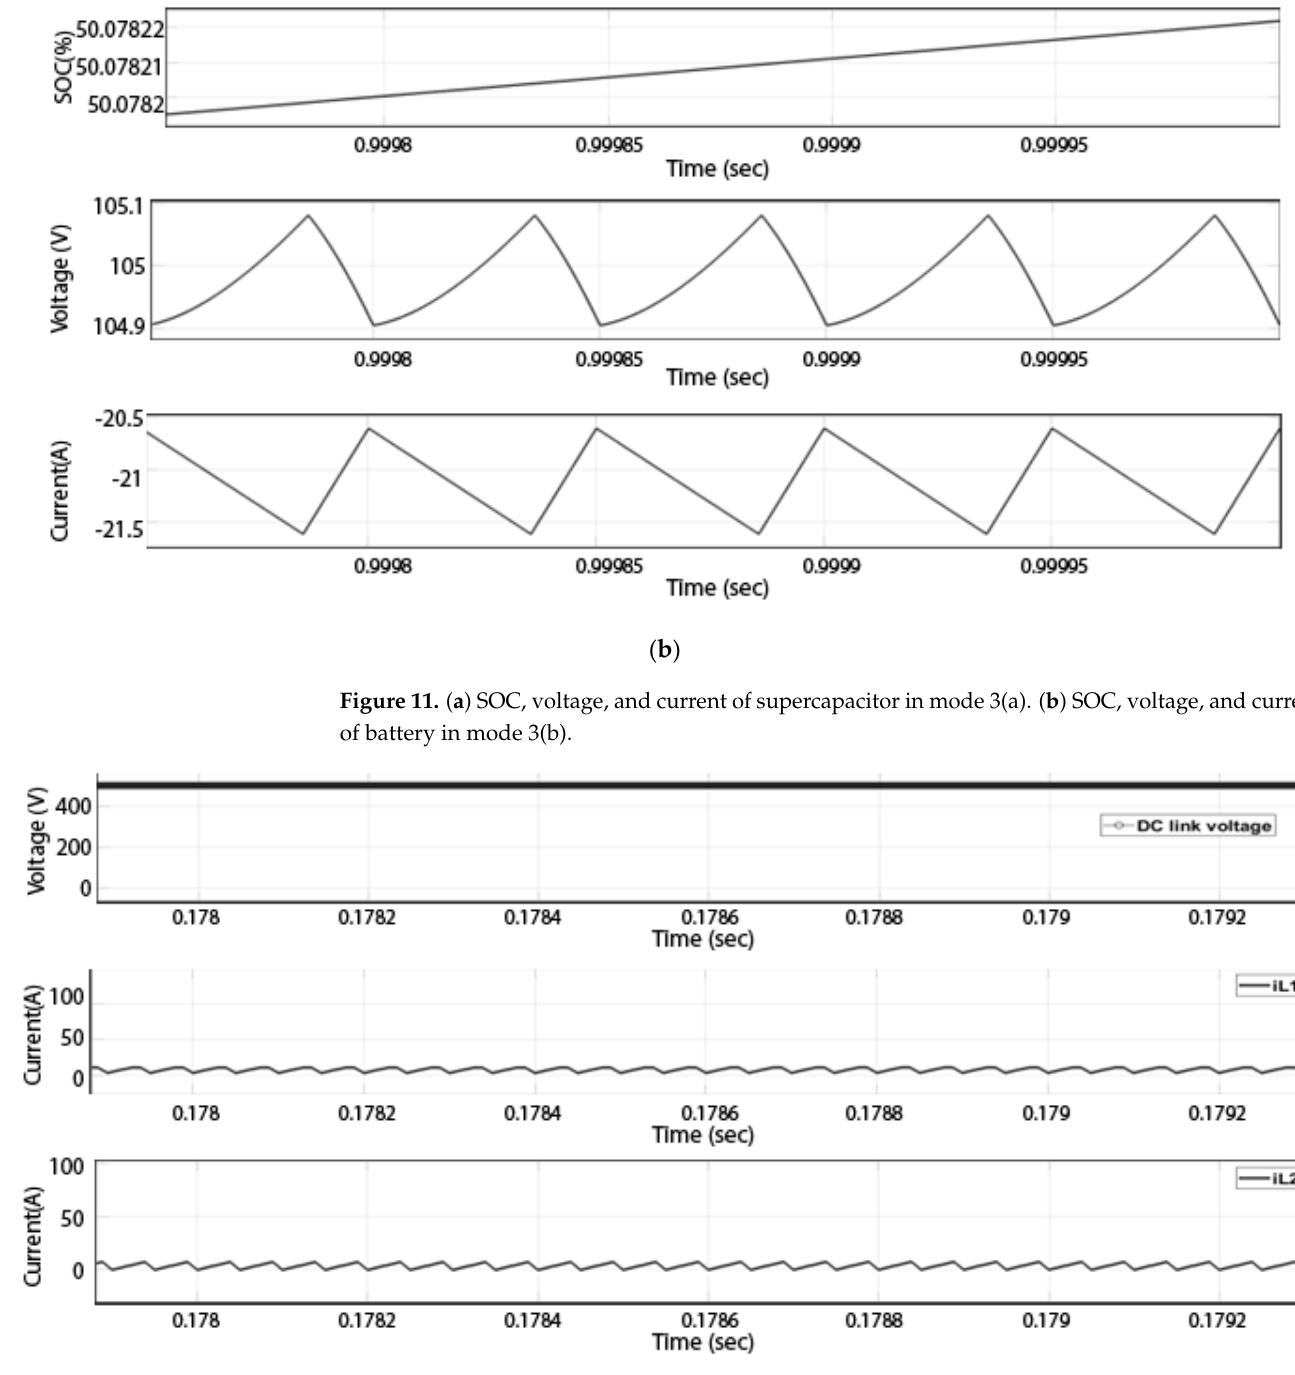
Figure 12. Currents of L 2 and L 1 and DC link voltage in mode 4.